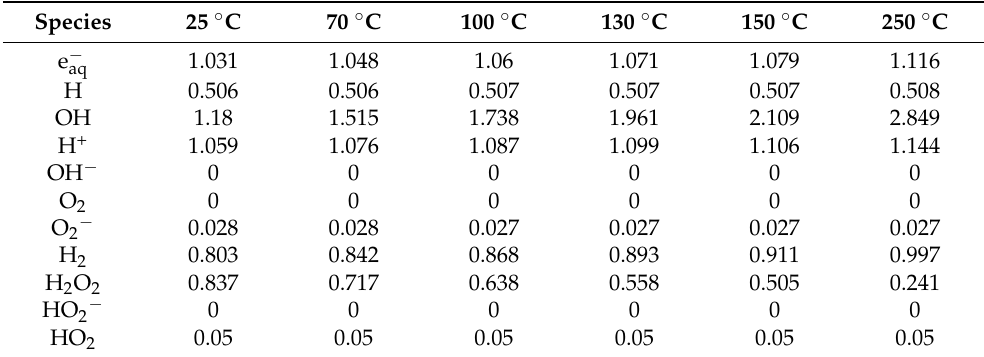
Table 19. Improved G-values (no./100 eV) for high-energy neutrons (14 MeV) at different tempera- tures (based on data from